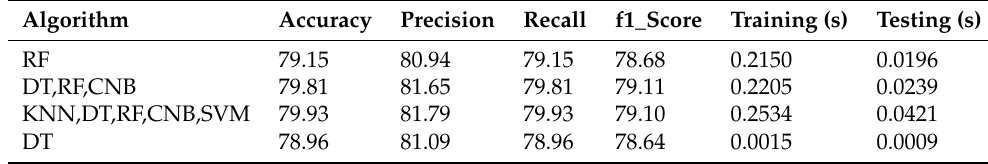
Table 7. Algorithms with the best performance in Part I and Part